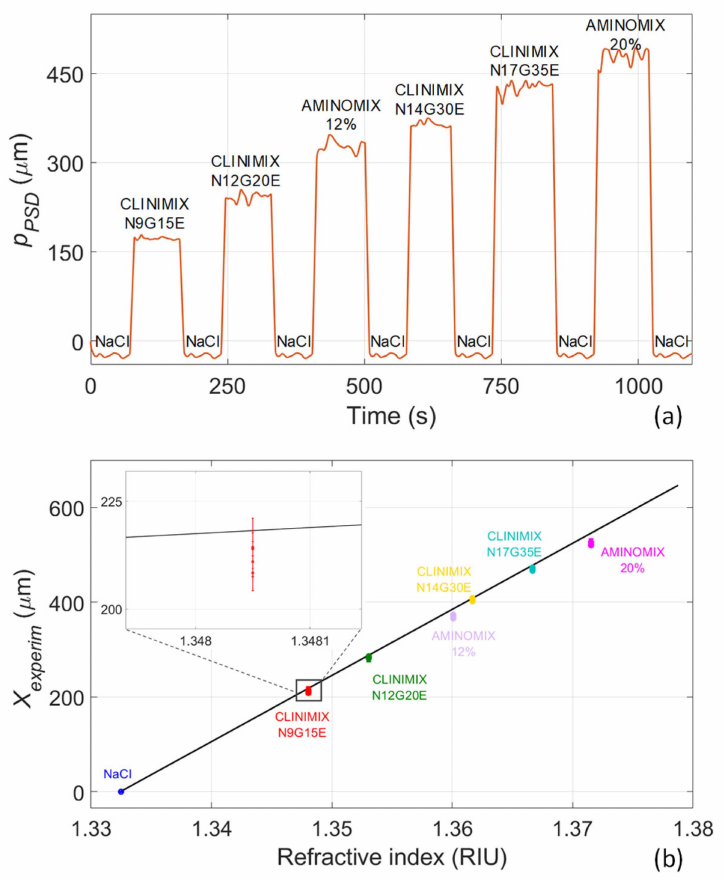
Figure 6. Experimental testing of PAN mixtures. ( a ) Beam position p PSD for reference solution (NaCl) and PAN fluids. ( b ) X experim for the tested PAN fluids in comparison with the calibration curve. In the inset, a zoomed view is reported, showing the four repetitions of the